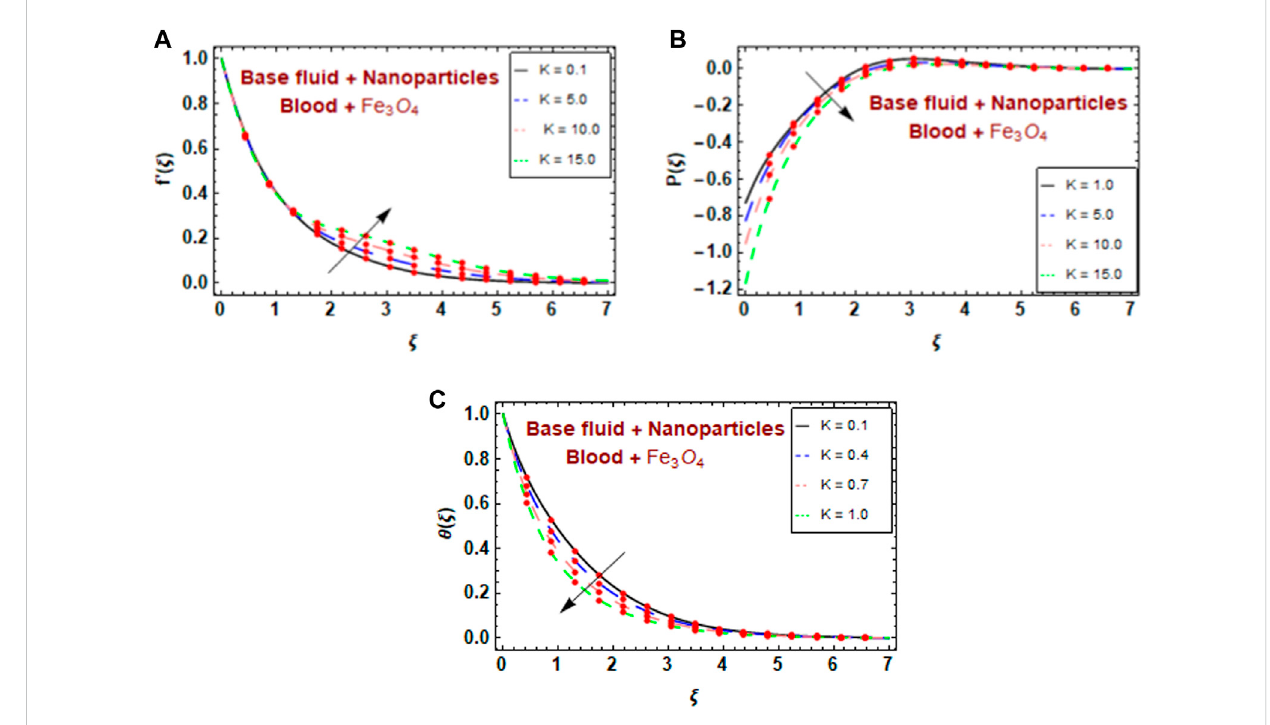
FIGURE 3 (A – C) Variations in f ′ ( ξ ) , p ( ξ ) , and θ ( ξ ) for distinct numbers of K .